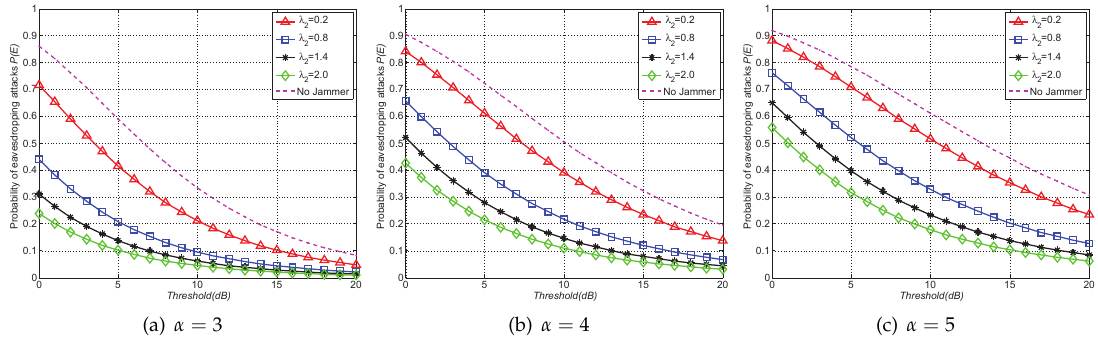
Figure 3. Probability of eavesdropping attacks P ( E ) with FJ-Ran scheme (PPP) versus Non-Jam scheme when α = 3,4,5 with SINR threshold T ranging from 0 dB to 20